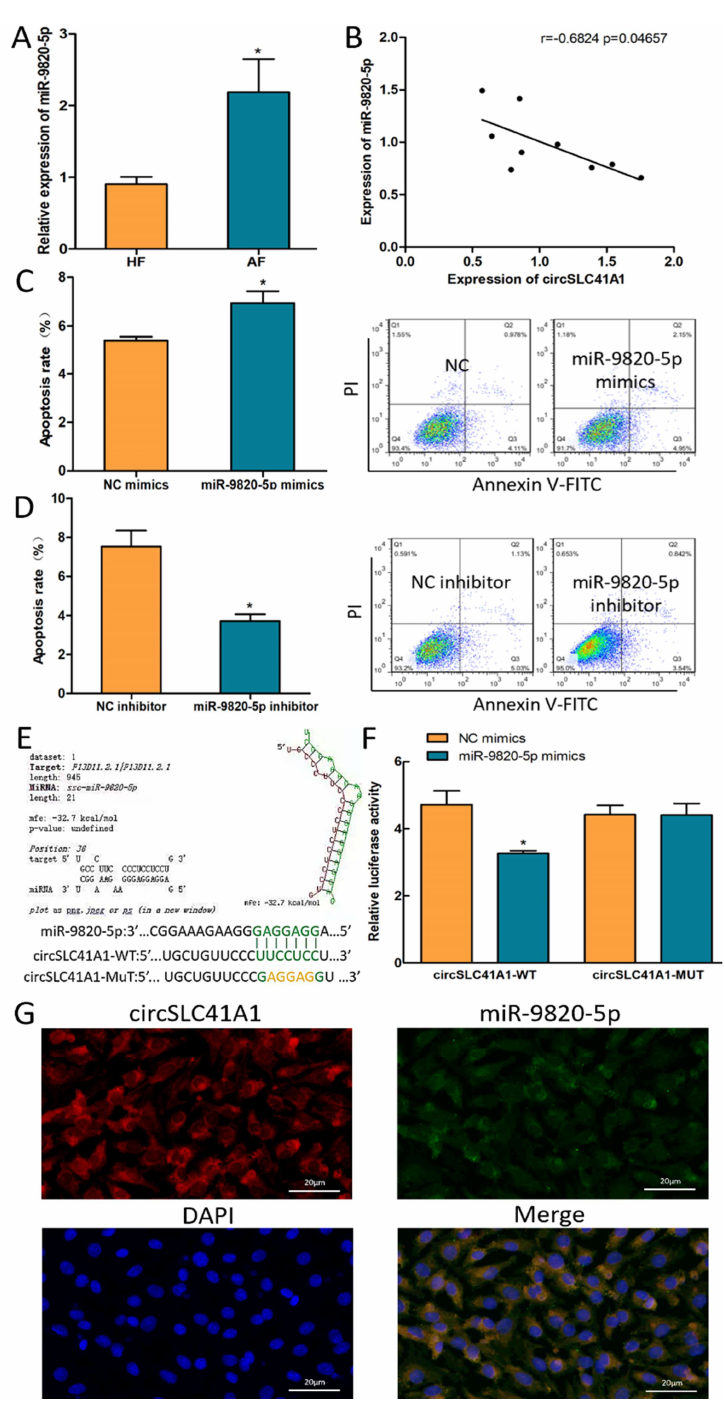
Figure 3. circSLC41A1 is a possible sponge for miR−9820−5p. ( A ) Differentially expressed miR−9820−5p in HFs and AFs detected by qRT−PCR. ( B ) Negative correlation between circSLC41A1 and miR−9820−5p expression levels in individual follicles ( n = 9). ( C,D ) Shift of GC apoptosis rates after miR−9820−5p mimics and inhibitor transfection detected by flow cytometry. ( E,F ) The binding of miR−9820−5p of circSLC41A1 was verified by dual−luciferase activity analysis. ( G ) The subcellular co−localization of circSLC41A1 (labeled by red fluorescence) and miR−9820−5p (labeled by green fluorescence) in GCs verified by FISH. The nuclei were stained by DAPI (blue). Scale bar: 20 μm. Data are expressed as the mean ± SEM of three experiments; * p < 0.05.